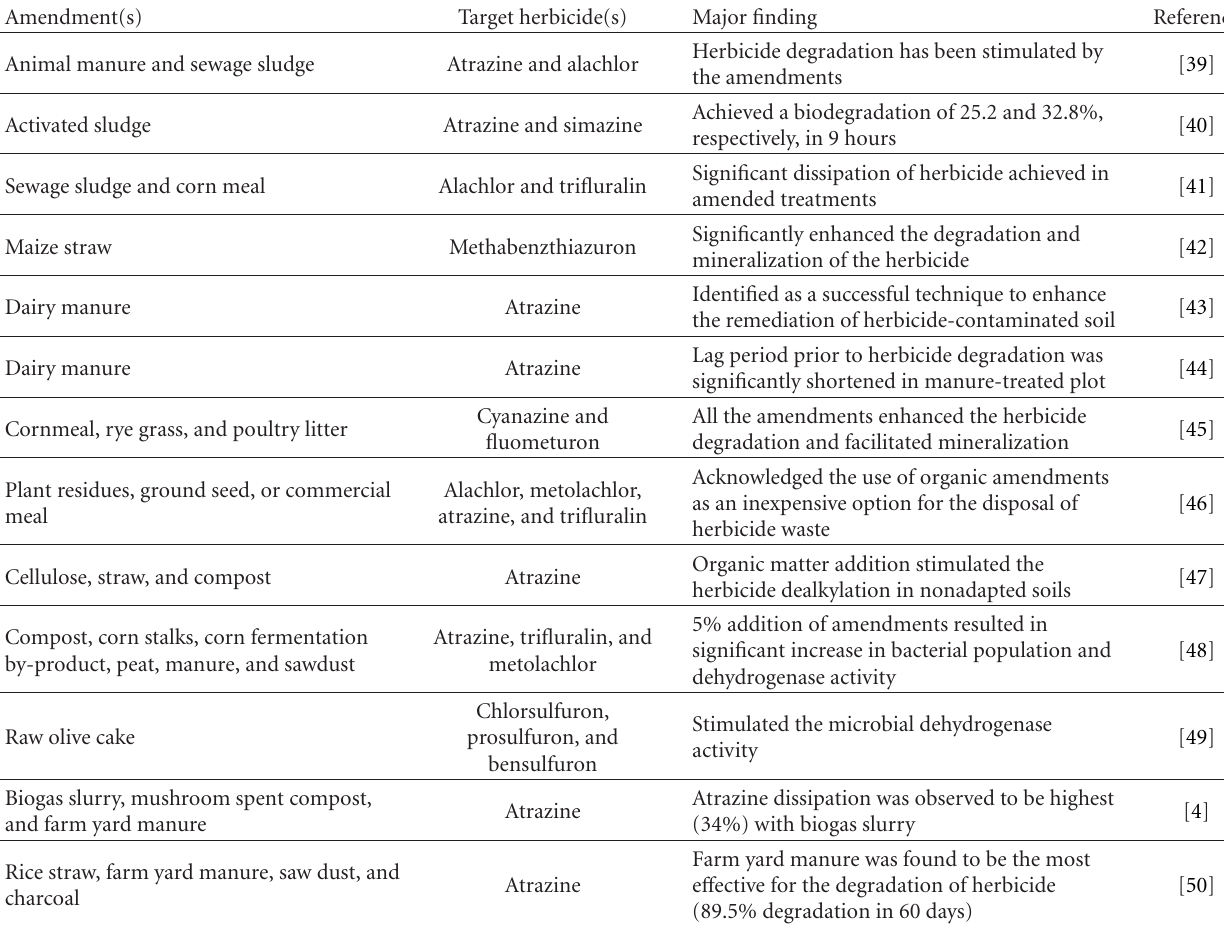
Table 1: Use of organic amendments and bioprocessed materials for the enhanced degradation of